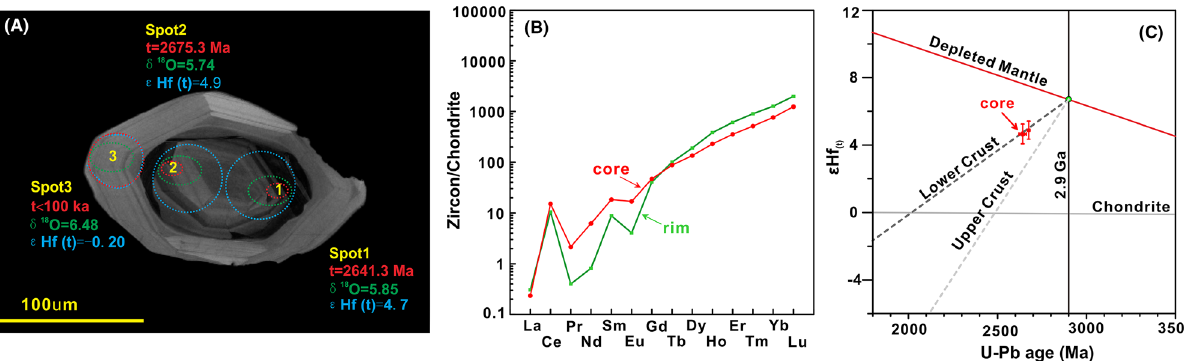
Figure 3. A representative zircon with an inherited core. ( a ) CL image of a zircon rim and core with the U–Th and U–Pb ages, δ 18 O and εHf (t) analysis locations and data shown. ( b ) REE diagram for the zircon’s rim and core. ( c ) Plot of εHf (t) versus U–Pb age for the inherited cores. The εHf (t) values and ages of the geochemical reservoirs after Griffin et al. 27 , Blichert-Toft and Albarede 28 , Amelin et al. 29 . The ages and Hf–O isotopes of Spots 1 and 2 are consistent with C1@07 and C1@08 in Table S2, respectively. The age of Spot 3 is inferred from its Light-CL image, and the Hf–O isotopes of Spot 3 are consistent with TVG-C1@20 in Table